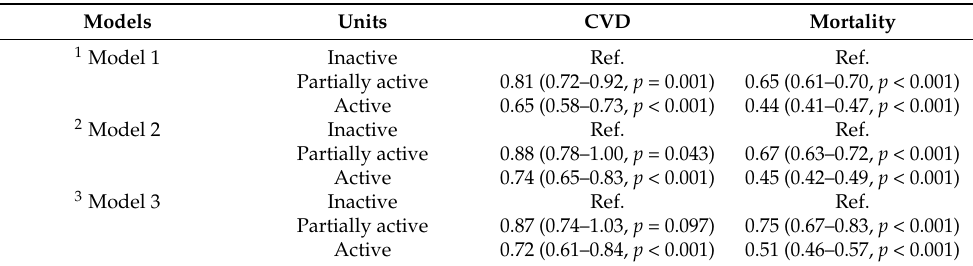
Table 2. Unadjusted and adjusted HRs (95% CI) of CVD and mortality according to physical activity among subjects with Type 2